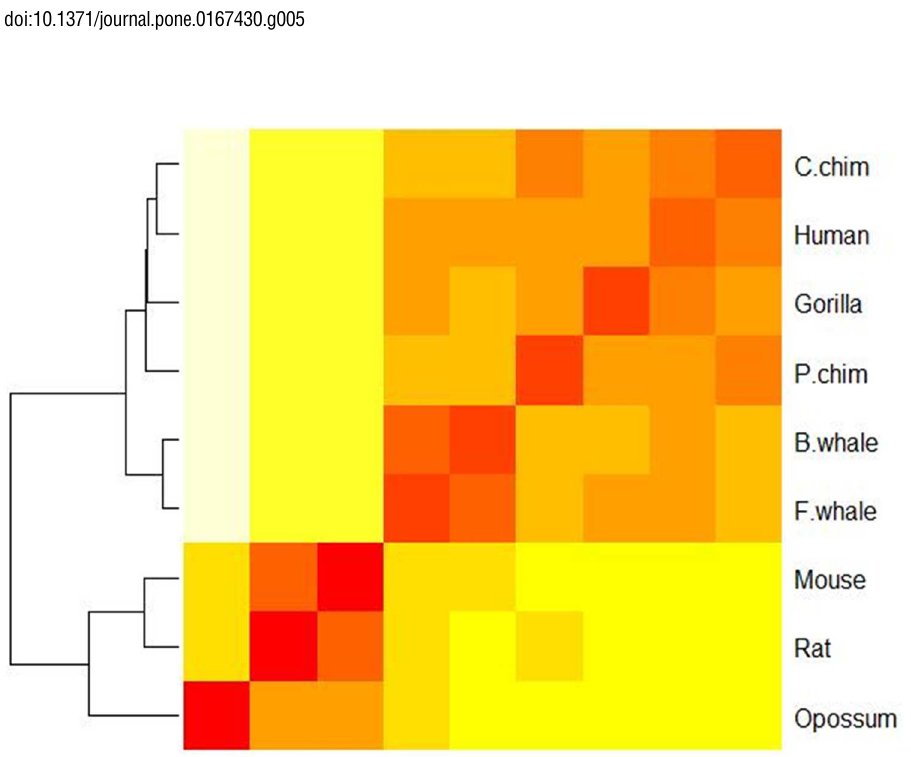
Fig 5. A heat map showing the similarity of nine species in the ND5 dataset based on the 20-D amino acid content ratio vector.